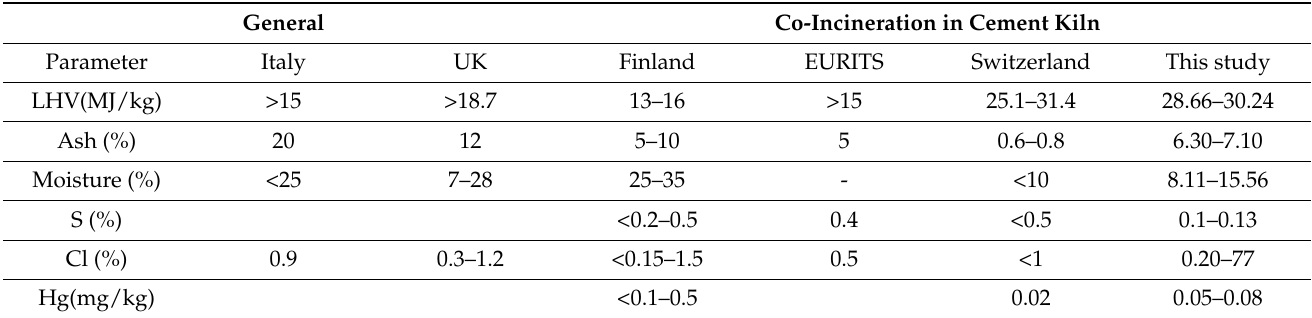
Table 5. Comparison of RDF characteristics with other quality